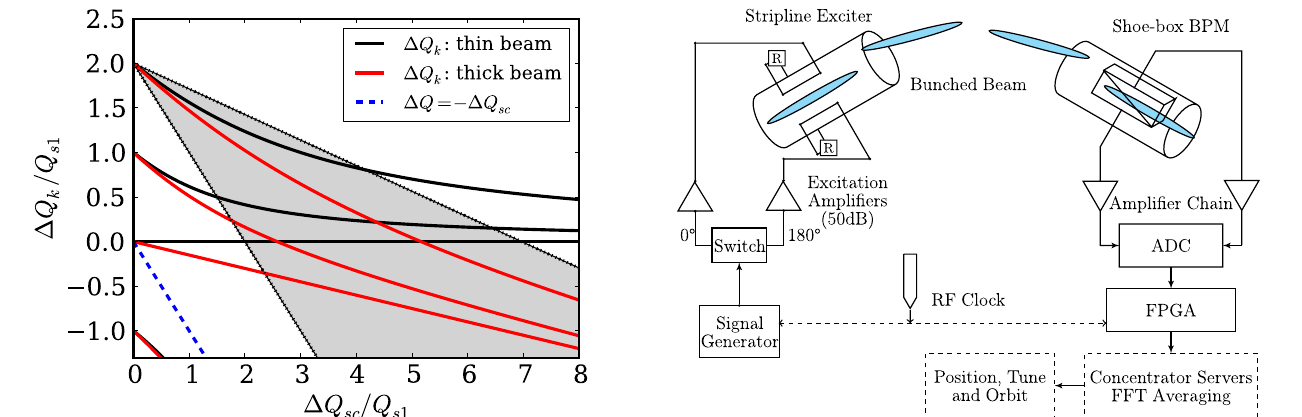
system.FIG. 5. Head-tail mode frequencies as a function of the space charge parameter. The grey shaded area indicates the incoherent band for a Gaussian bunch and k ¼ 2 . The red curves represent the head-tail mode frequencies obtained for q c ¼ 0 : 15 q sc